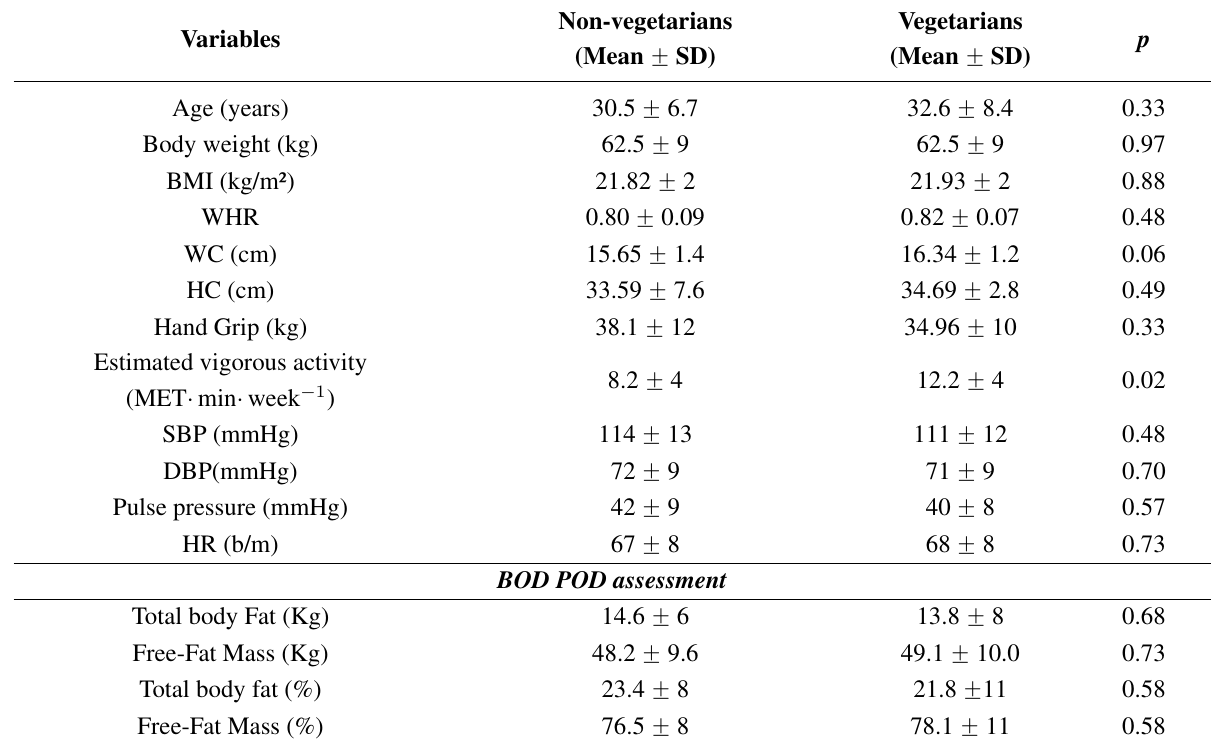
Table 1. General, anthropometric and dietary intake characteristics among 26 vegetarian and 26